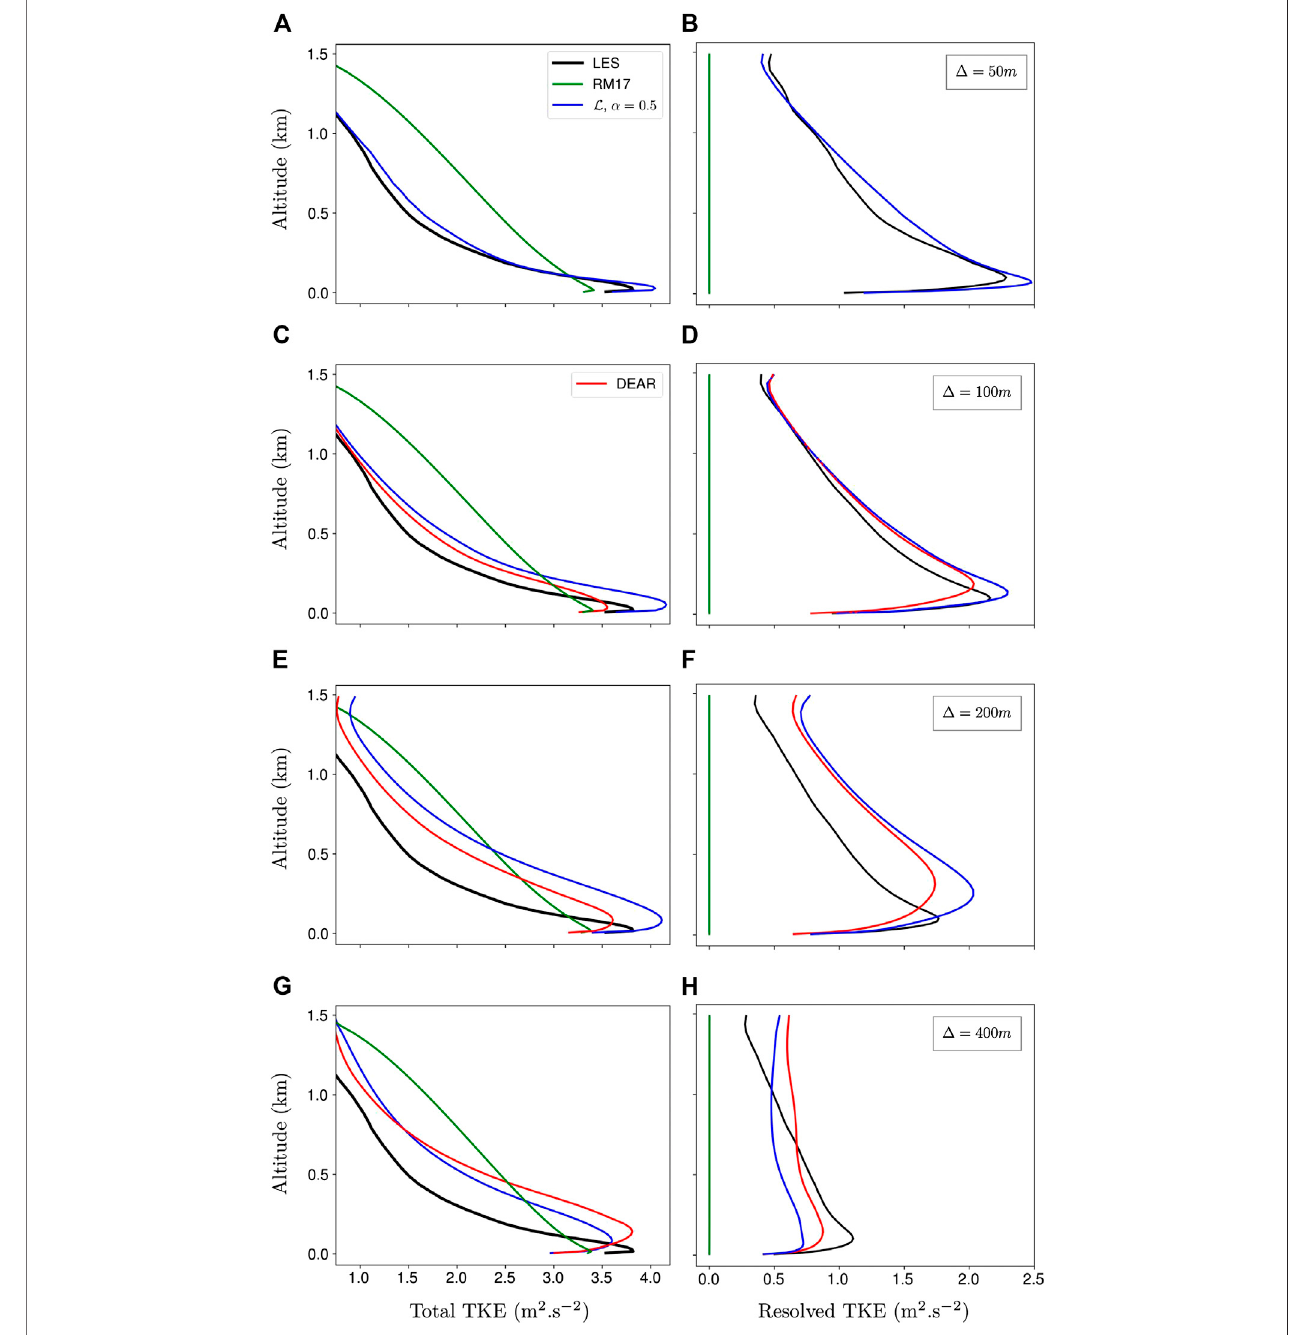
FIGURE 7 | Vertical pro fi les of total (left column) and resolved (right column) TKE obtained in the MUST neutral con fi guration from LES (black), RM17 (yellow), L DEAR (red) and L (blue) at 50, 100, 200, and 400 m horizontal resolution.